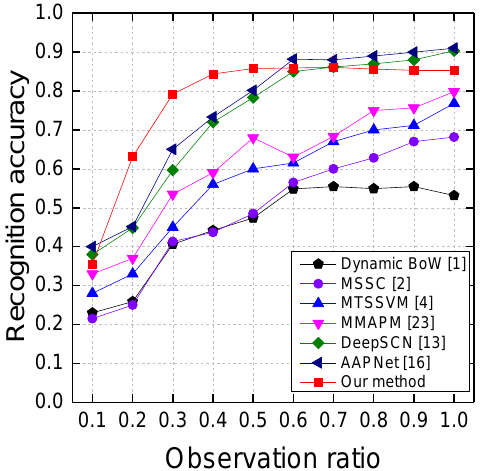
Figure 5. Prediction results on the BIT